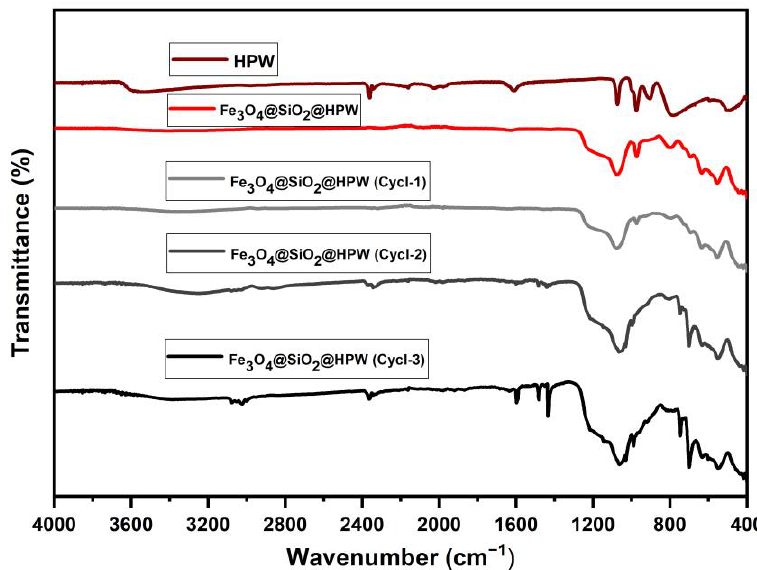
Figure 15. FTIR spectra of the HPW, supported HPW, and reused catalyst for three cycles. Table 8. Acetalization of glycerol with benzaldehyde over other solid acid catalysts.